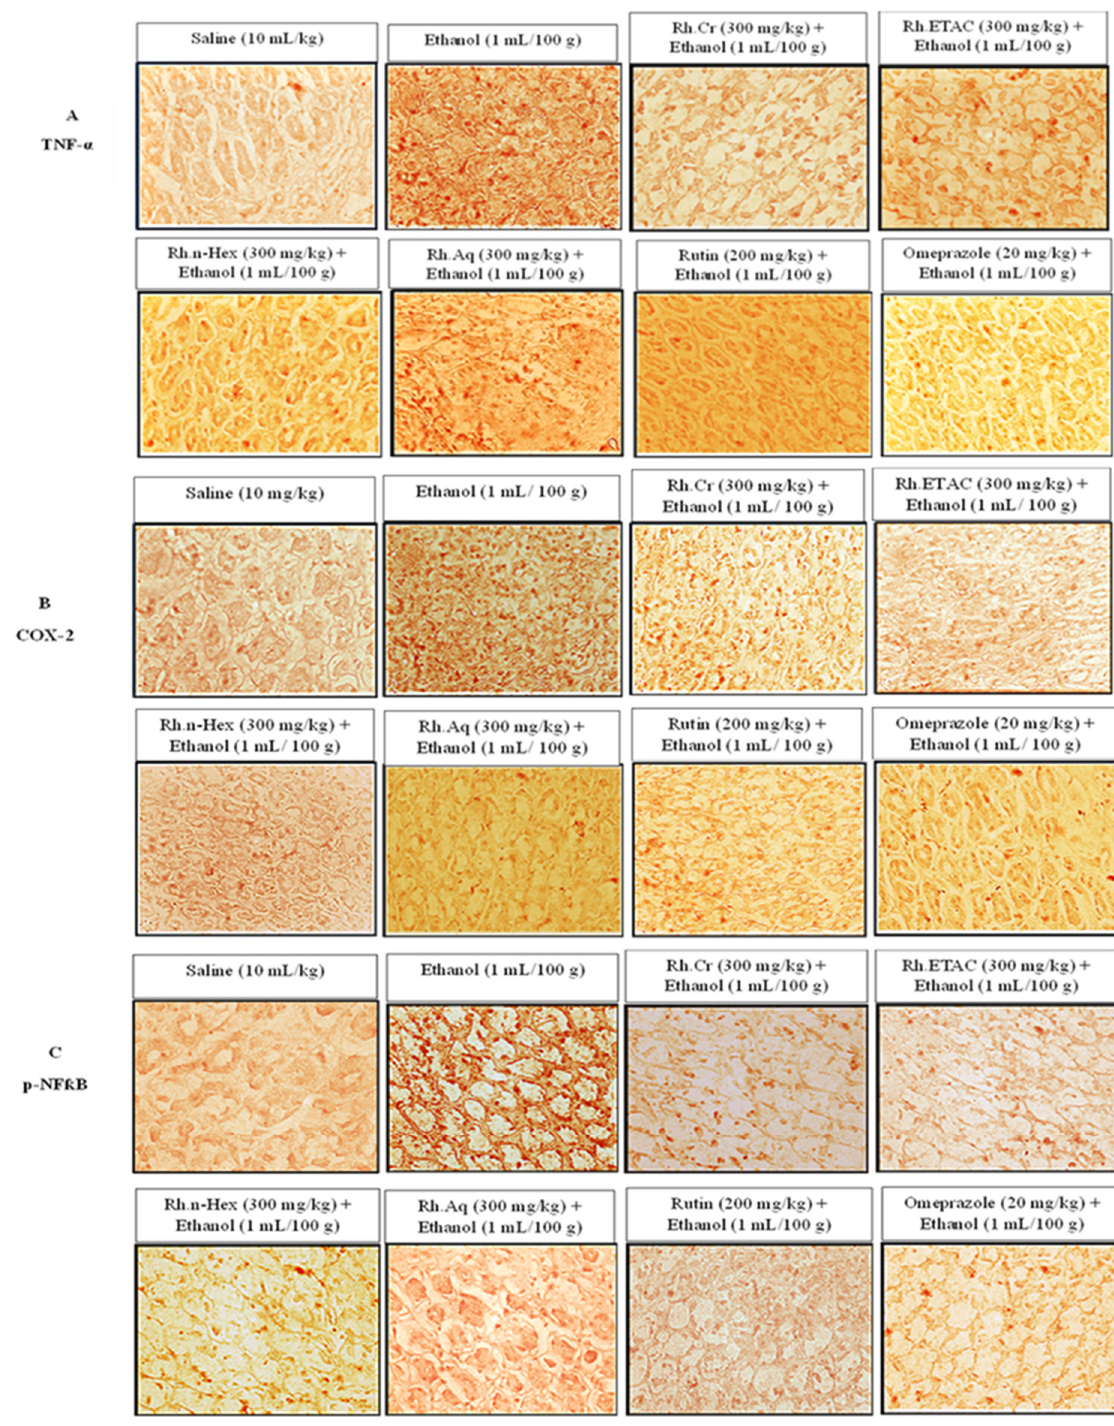
Figure 9. Effect of Rumex hastatus crude extract (Rh.Cr), n-hexane (Rh.n-Hex), ethyl acetate (Rh.ETAC), aqueous fraction (Rh.Aq), rutin and omeprazole on apoptotic markers ( A ) Tumor necrosis factor alpha (TNF- α ), ( B ) cyclooxygenase 2 (COX-2) and ( C ) phosphorylated-nuclear factor kappa B (p-NF κ B) in ethanol-treated rats gastric tissues using the immunohistochemical technique. Bar 50 µm, magnification 40×.